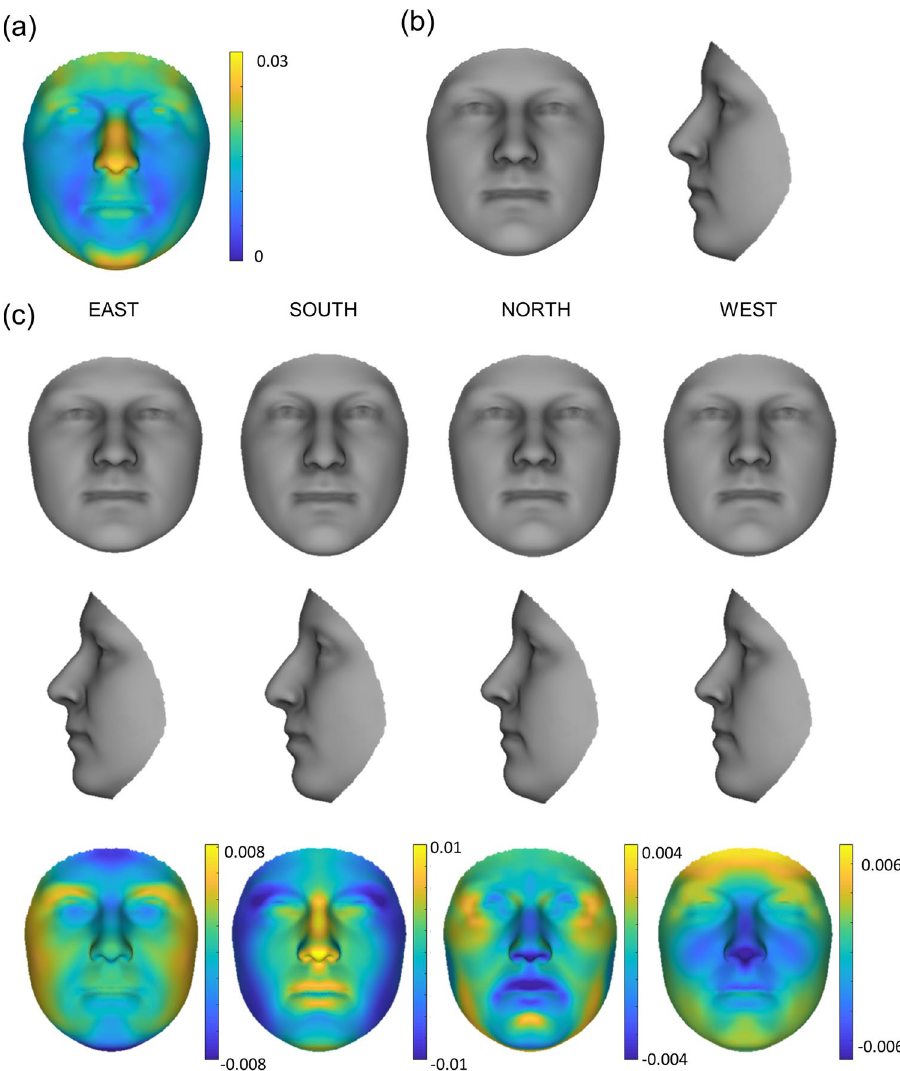
Figure 4. Regional ancestry effect: ( a ) maximum ancestry shift per landmark, ( b ) average face with ancestry removed for comparison, ( c ) average regional ancestry effect multiplied (4X) and normal displacement maps (magnitude of inward/outward movement) of ancestry effect (n = 186 per